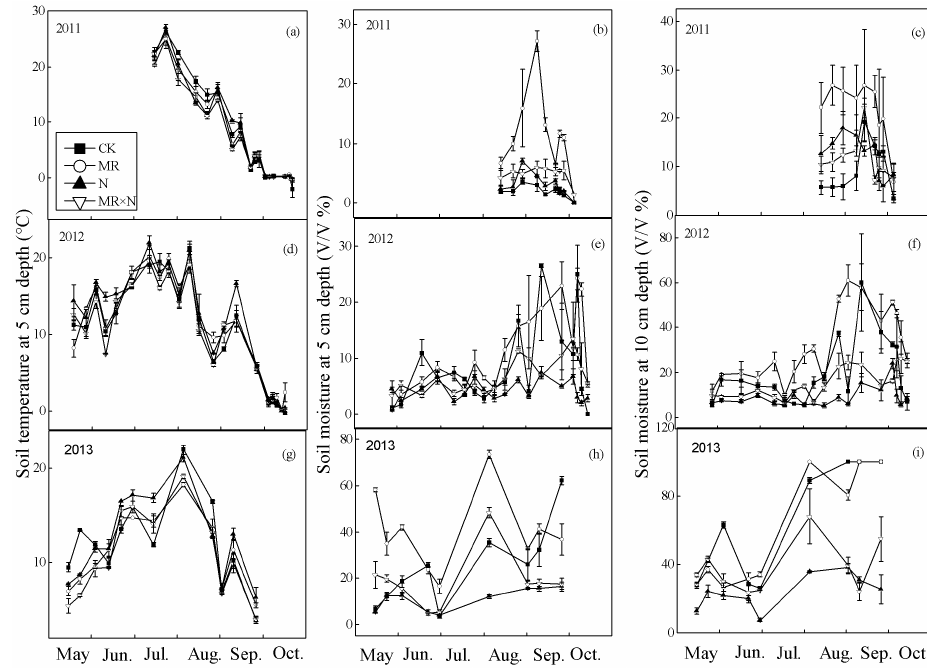
Figure 1. Temporal dynamics of soil temperature at 5cm depth (a, d, g) , soil moisture at 5cm depth (b, e, h) and soil moisture at 10cm depth (c, f, i) during the growing seasons in 2011, 2012 and 2013. Data are daily averages for each treatment ( ± SE, n = 3). CK, control; MR, moss removal; N, N addition; MR × N, moss removal plus N